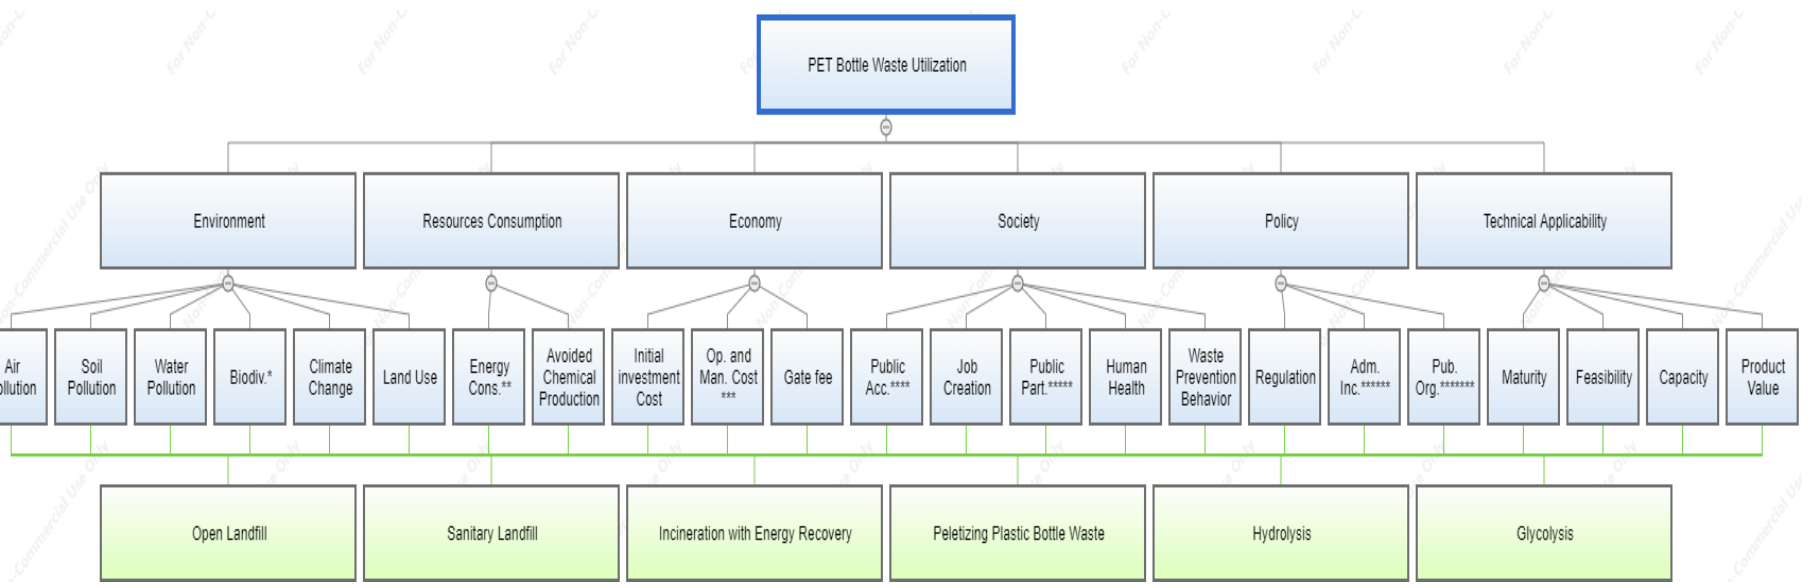
Figure 2. Analytical hierarchy construction. Annotations: * biodiversity; ** energy consumption; *** operation and management cost; **** public acceptance; ***** public participation; ****** administrative incentive; and ******* public organization.